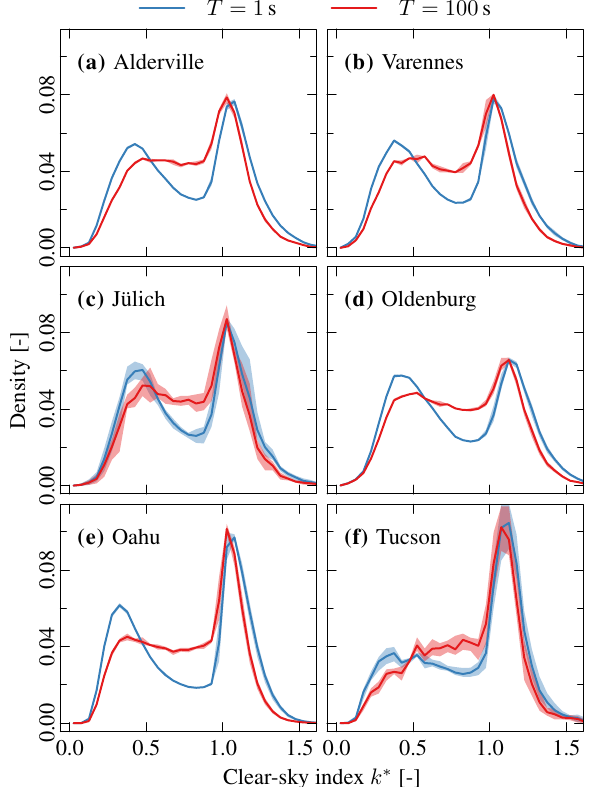
∗ under mixed-sky con- Figure 2. Distributions of clear-sky index k ditions for two averaging times T = 1 and T = 100s and all six locations, estimated from histograms using a bin width of 0.05. The spread across multiple single-sensor distributions is indicated us- ing semi-transparent coloring, while the solid lines are derived by averaging the single-sensor densities in each